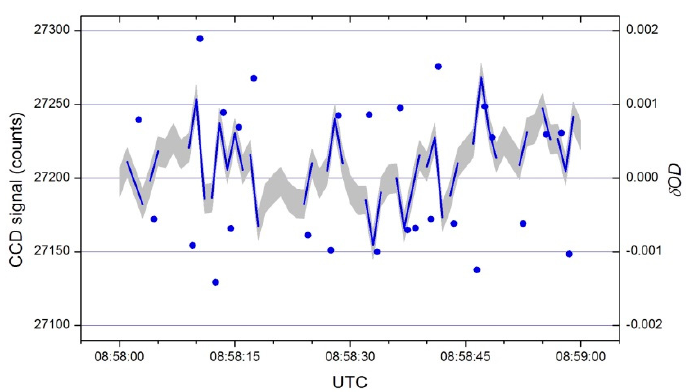
Figure 5. Evolution of the measured flux at 500 nm (left axis, grey band is signal plus / minus uncertainty), significant transitions (according to condition in Equation (9); blue lines), and derived changes in apparent optical depth (blue points, referred to the right axis), for a one-minute period of very clear sky in 2 June 2015.